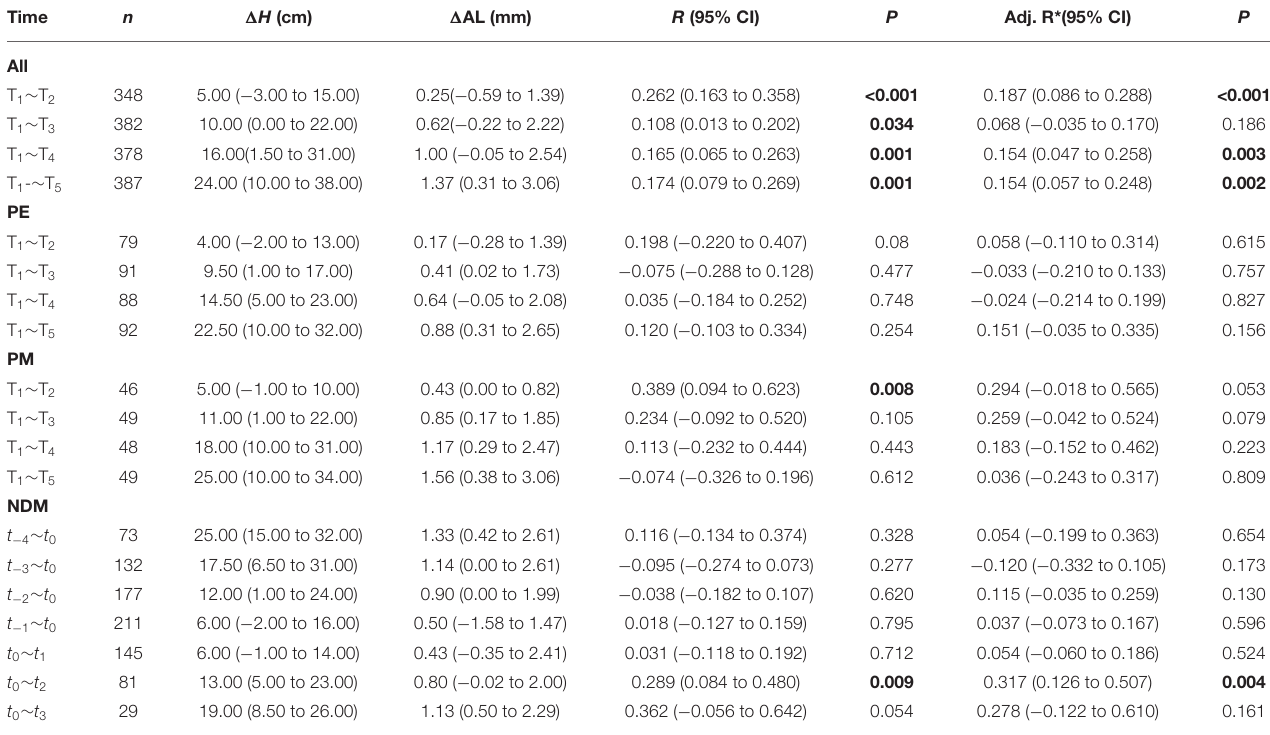
TABLE 5 | Correlation between changes in height and changes in AL in different